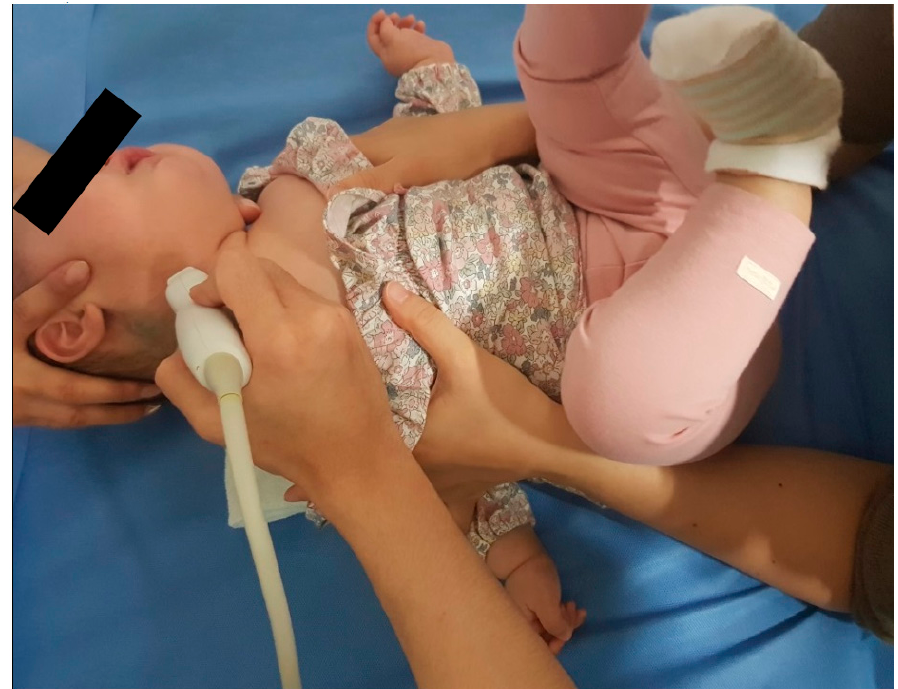
Figure 1. The position of the infant during ultrasonography to the sternocleidomastoid (SCM) muscle in the transverse plane.